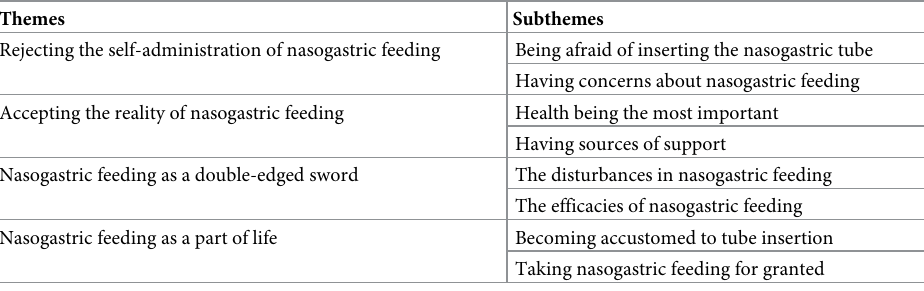
Table 2. Themes and subthemes of the